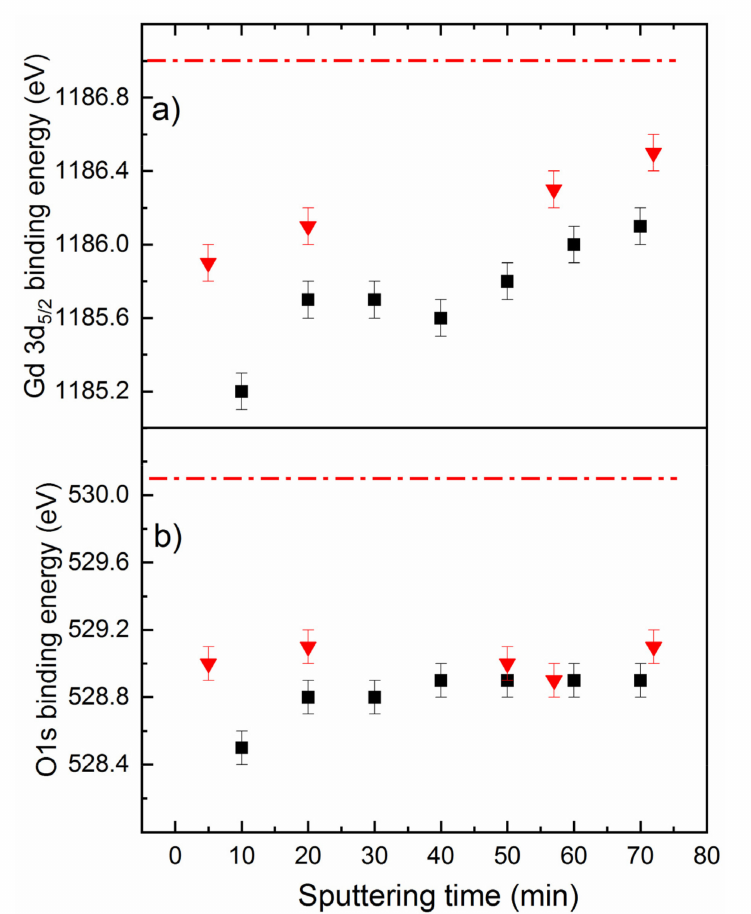
Figure 4. Binding energies as a function of the sputtering time for the YBCO-Gd 5% (black squares) and 10% (red triangles) films deposited by standard process. ( a ) Gd 3d 5 / 2 binding energies; ( b ) O1s binding energies. The red dot-dashed lines indicate the binding energy position of the Gd 3d 5 / 2 and O1s core-levels measured in Gd 2 O 3